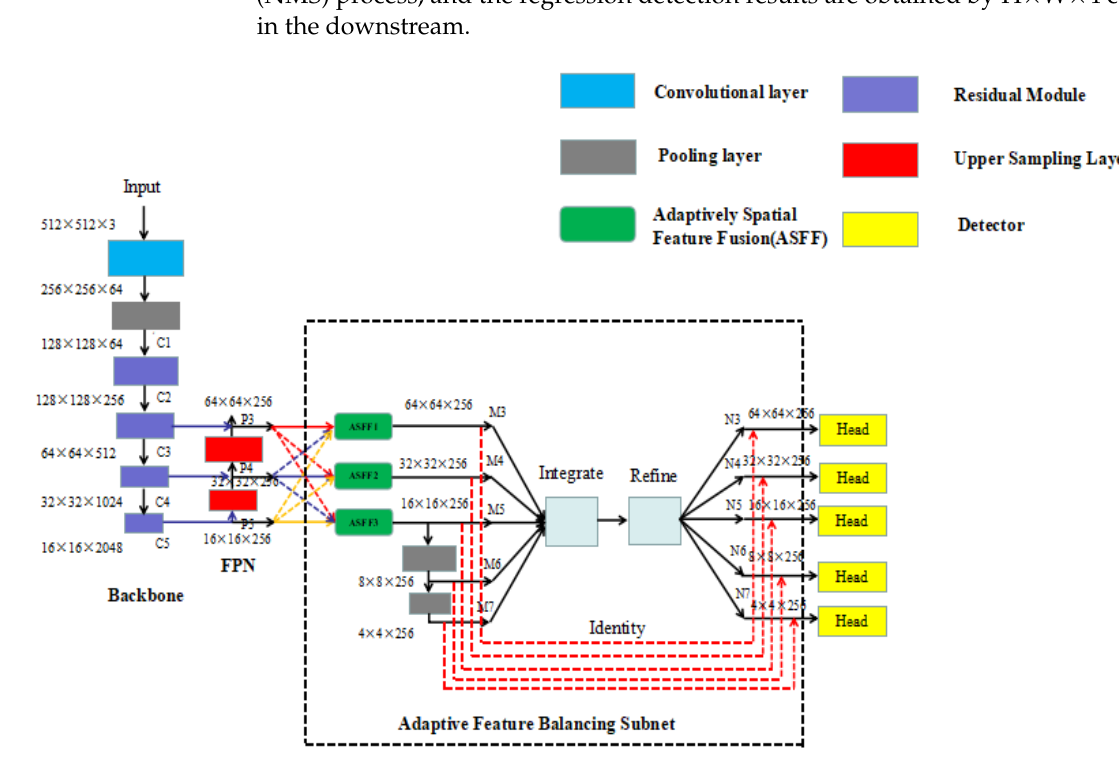
Figure 2. The algorithm network architecture of this